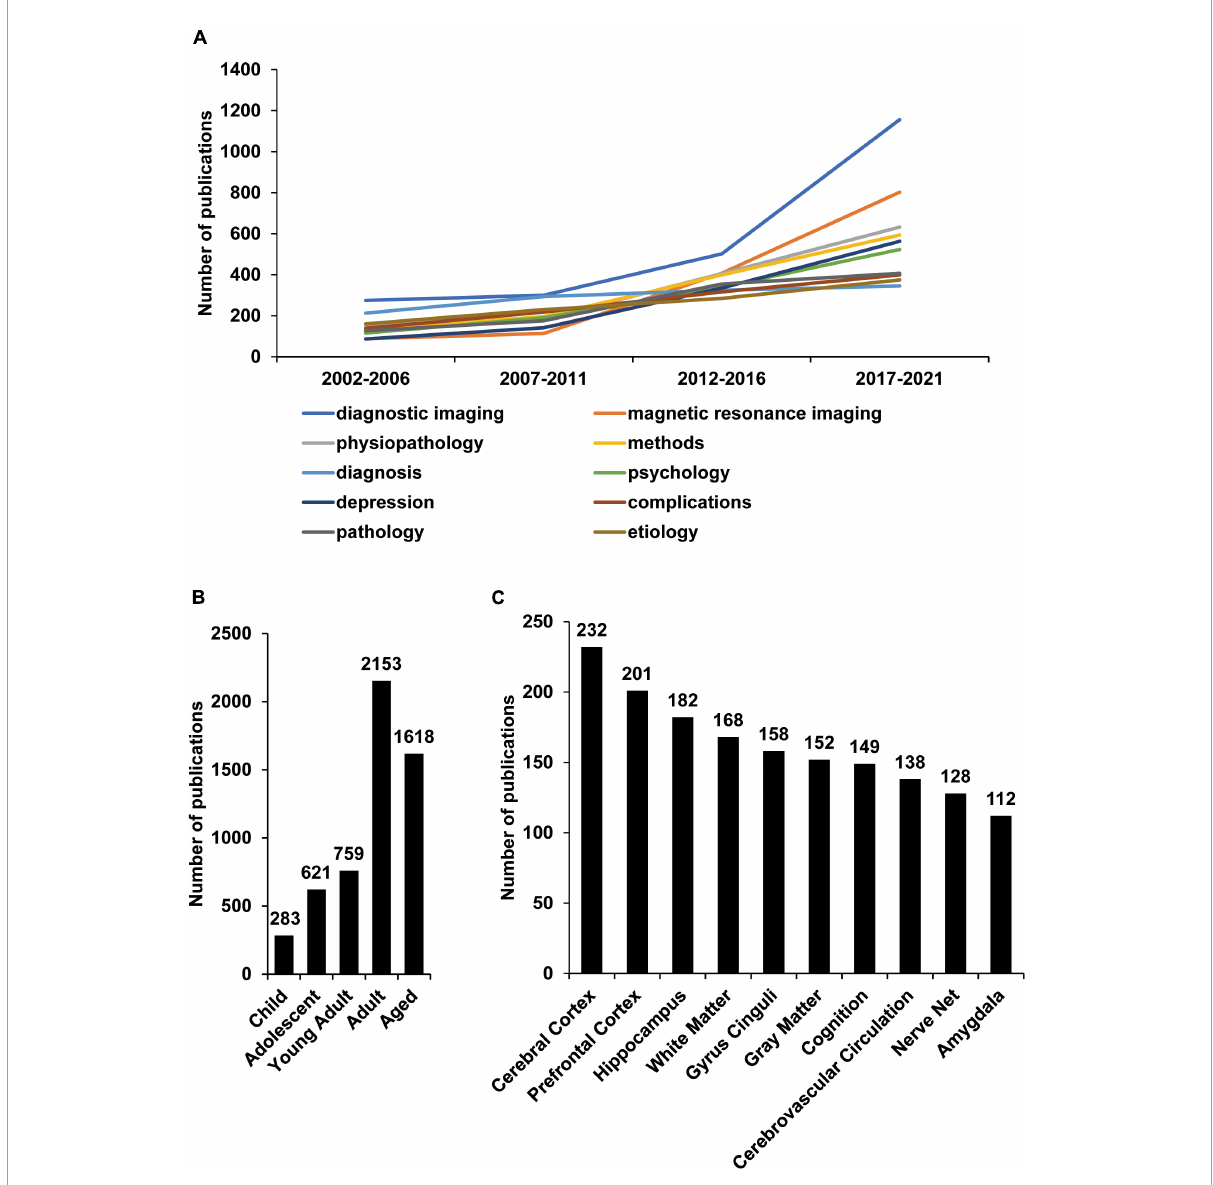
FIGURE4 Research changes in depression and radiology through a study of MeSH terminology. R extracted significant MeSH terms from publications listed in the PubMed database according to the publication topic. Each publication is defined by the PubMed database, which can indicate the general content of the paper research. Each publication contains multiple MeSH terms, which extracted by R and Python. (A) Ten of the most widely studied MeSH terms and their number (No.) of publications per year. “diagnostic imaging,” “MRI,” and “physiopathology” were the most frequently studied research fields in the last 20 years. (B) The number of publications studying different age groups. Adults is the most studied group. (C) The most studied brain structures and their number of publications. The Cerebral Cortex, Prefrontal Cortex, and Hippocampus